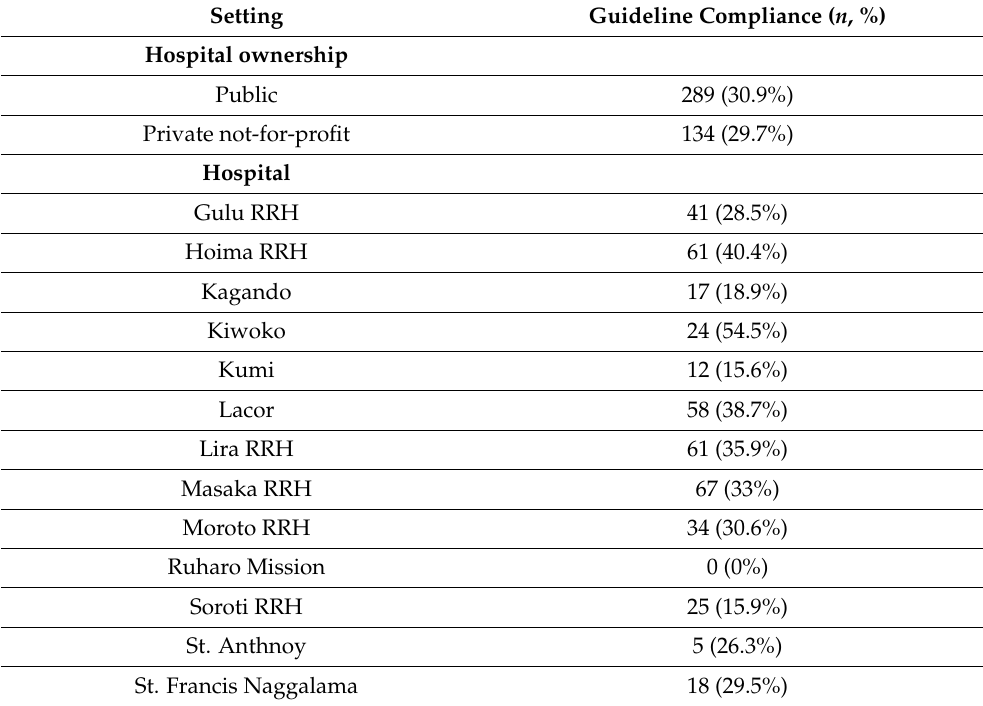
Table 6. Antibiotics prescribed in compliance with Uganda Clinical Guidelines by